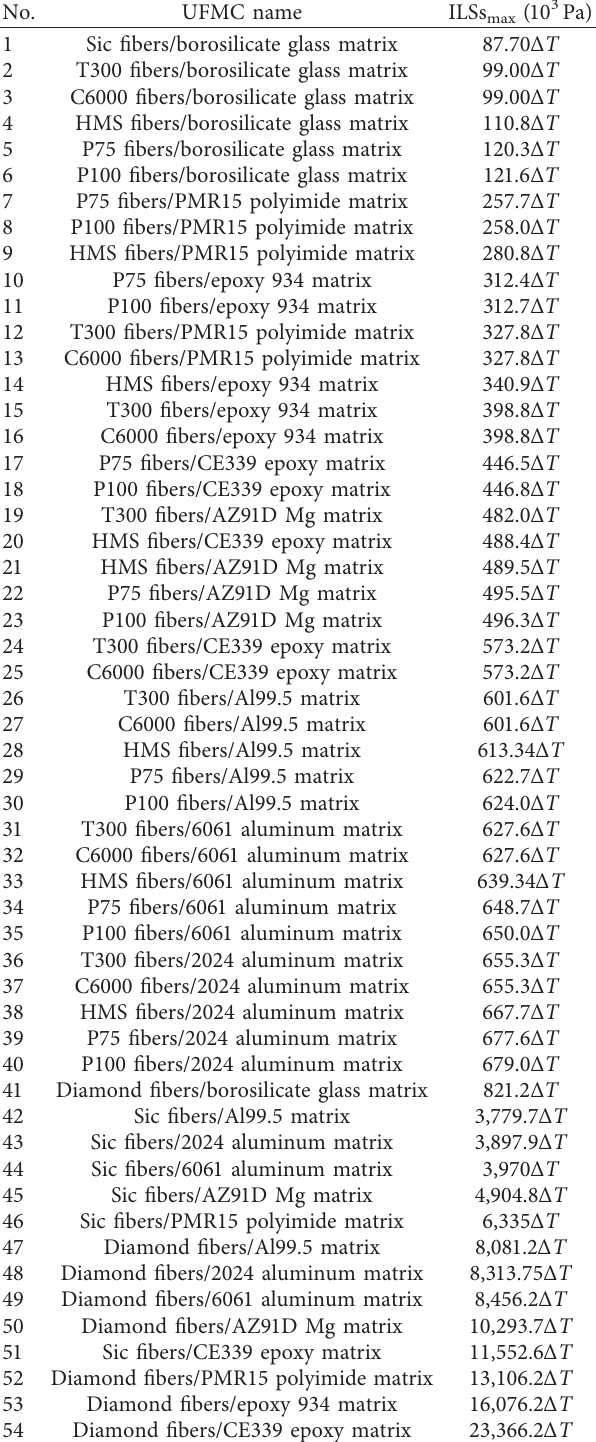
Table 3: Ranking of UFMCs based on ILSs values in Tables 1 and 2.